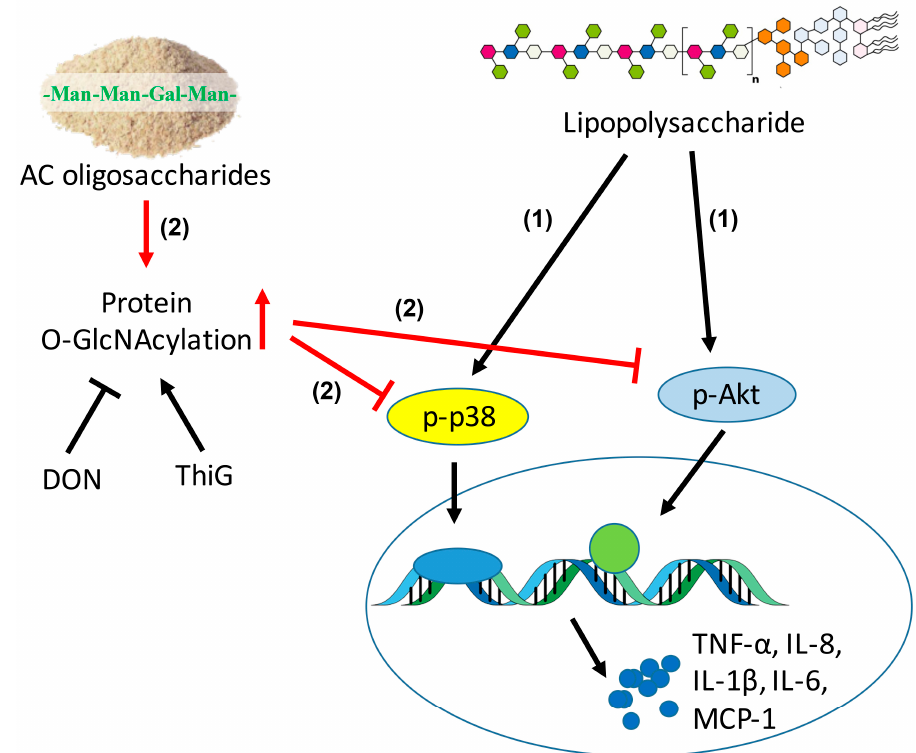
Figure 8. The schematic diagram that ACHO inhibited LPS-induced inflammation. (1) LPS induced the over-expression of IL-6, IL-8, IL-1 β , TNF- α and MCP-1 at mRNA levels by up-regulation of p-p38 and p-Akt; (2) ACHO promoted the protein O -GlcNAcylation, which further suppressed phosphorylation of p38 and Akt and subsequently inhibited LPS-mediated inflammation.